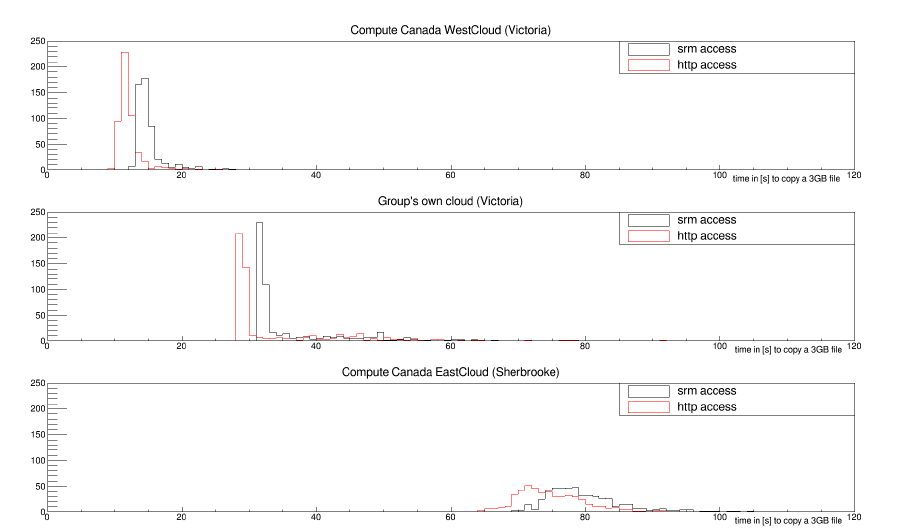
Figure 4: Time distribution for copying 500 3GB files directly from the UVic Grid storage, initiated by clients on di ff erent clouds using the HTTP protocol (in red); in addition to previ- ous test